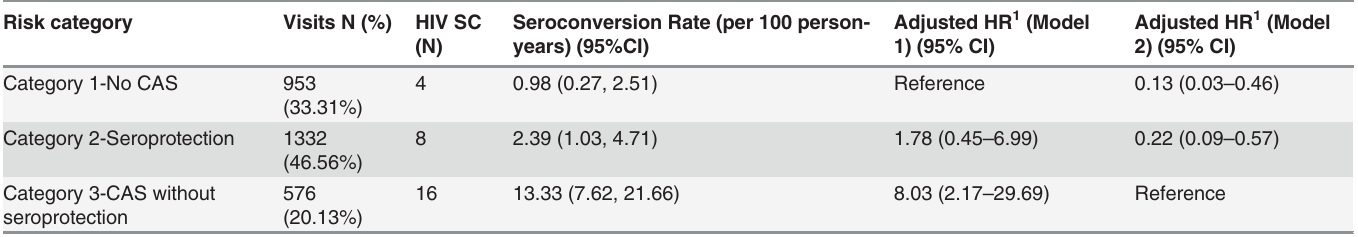
Table 3. Adjusted relative hazards ratio of HIV seroconversion among Black MSM in HPTN 061. Risk